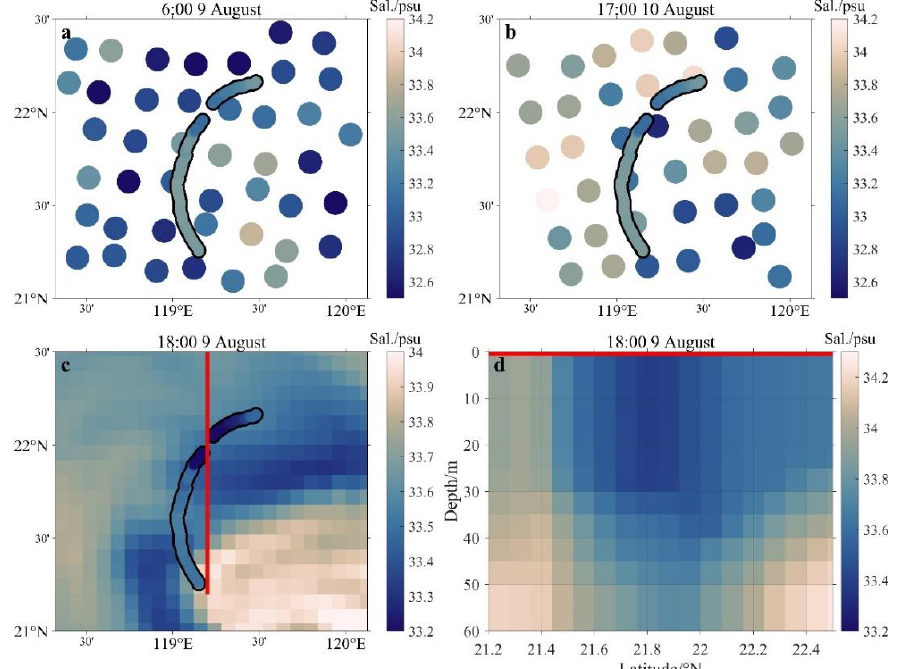
Figure A1. ( a , b ) Surface salinity from SMAP (colored dots) and surface salinity (~5 m) from SBE-21 (colored thick lines). ( c ) Sea surface salinity (at 5 m depth) from HYCOM Analysis (colored) and from the SBE-21 (colored thick lines). Red line indicates the vertical transect in ( d ). ( d ) The transect of salinity along the red line in ( c ).